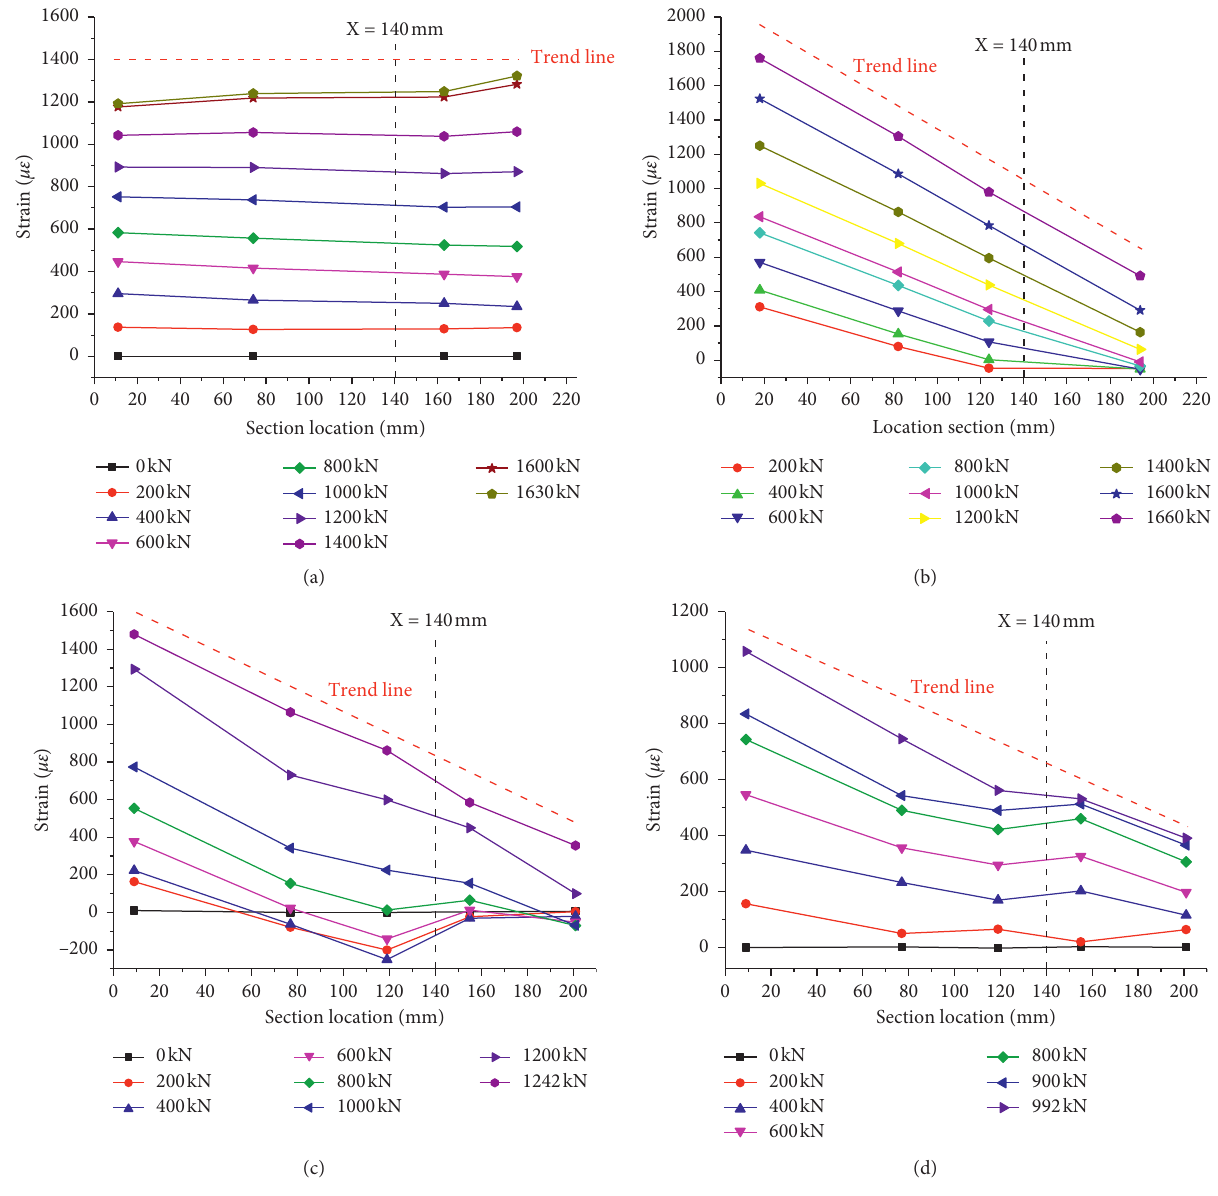
Figure 9: Strain distribution of group N . (a) N70-L-00. (b) N70-L-20. (c) N70-L-30. (d)